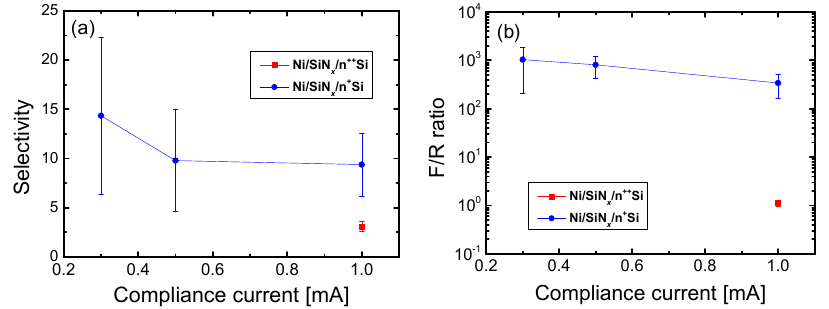
Figure 10. Nonlinearity as a function of the compliance current: ( a ) the selectivity and ( b ) the F/R ratio for Ni/SiN x /n + Si device and Ni/SiN x /n ++ Si devices.